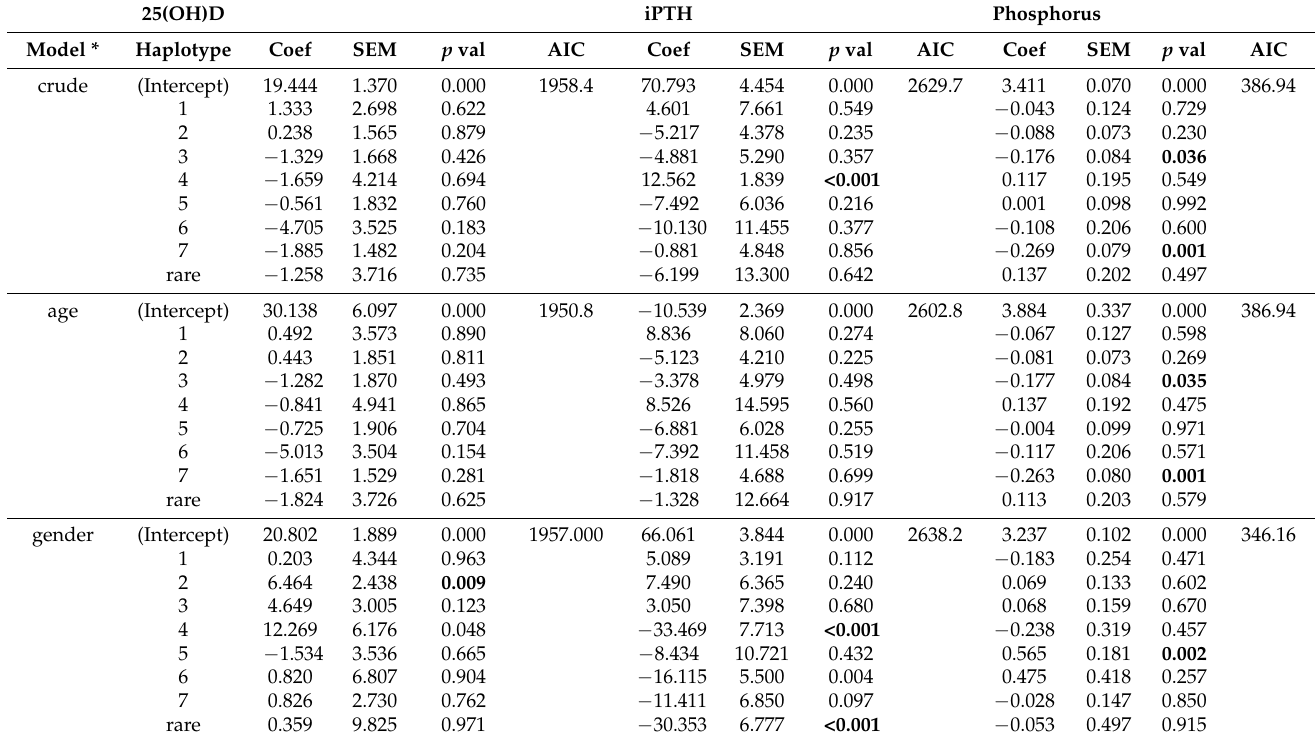
Table 6. The association of haplotypes with mineral metabolism biomarkers (25(OH)D, iPTH,